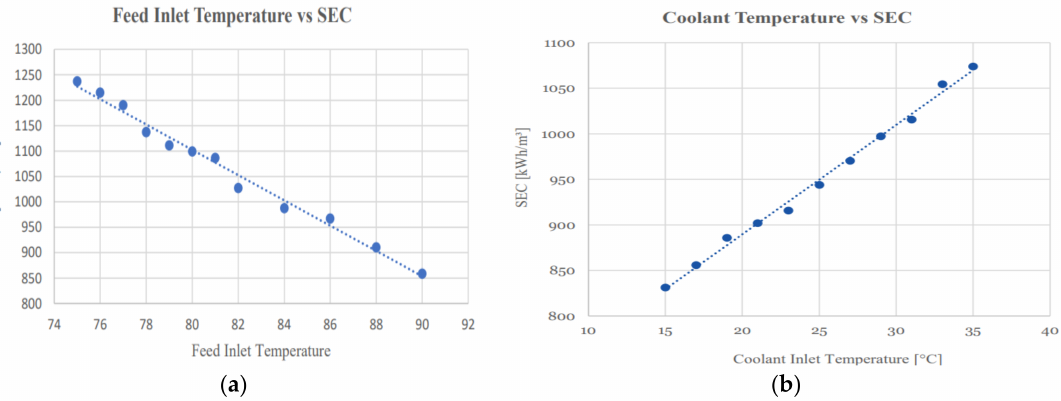
Figure 8. Effects on increasing Feed/Coolant Inlet temperature versus SEC: ( a ) Effects on increasing feed inlet temperature vs. resulting SEC. ( b ) Effects on increasing coolant inlet temperature vs. resulting